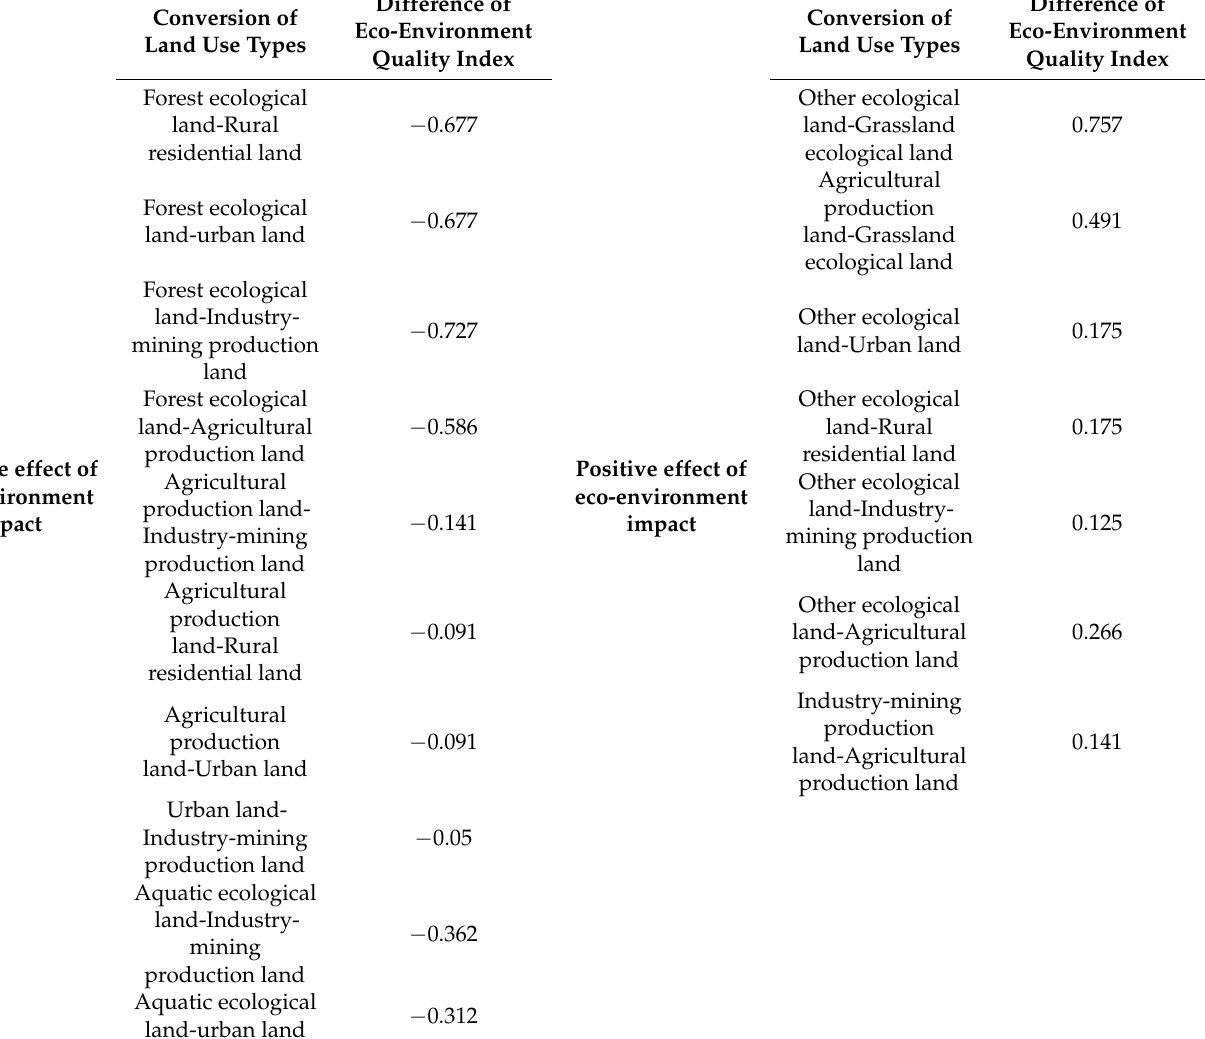
Table 2. Eco-environment effects of land use function transition and changes in the eco-environment quality